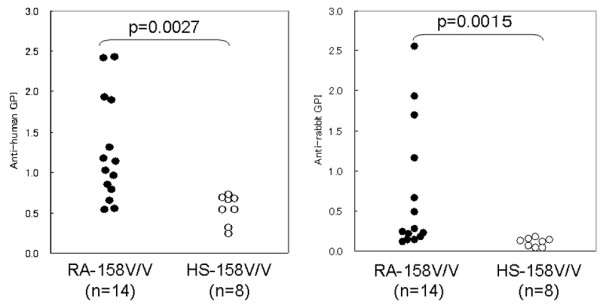
Higher titres of anti-human and anti-rabbit GPI antibodies in FCGR3A-158V/V RA patients versus healthy individuals. In individuals homozygous for the FCGR3A high affinity V/V genotype (14 RA patients and 8 healthy individuals), both anti-human GPI antibodies and anti-rabbit GPI antibodies were significantly elevated in the RA group (P = 0.0027 and P = 0.0015 for anti-human GPI antibodies and anti-rabbit GPI antibodies, respectively, by Mann–Whitney U-test). GPI, glucose-6-phosphate isomerase; RA, rheumatoid arthritis.